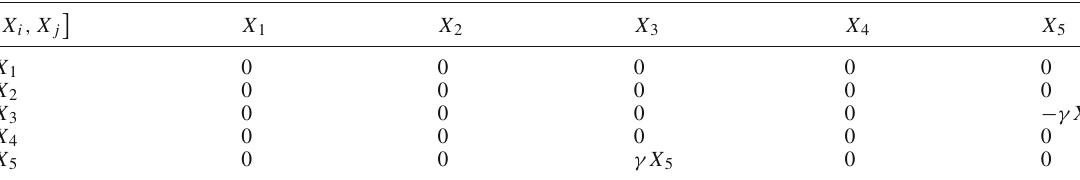
Table 3 Algebra of generators of Eq.